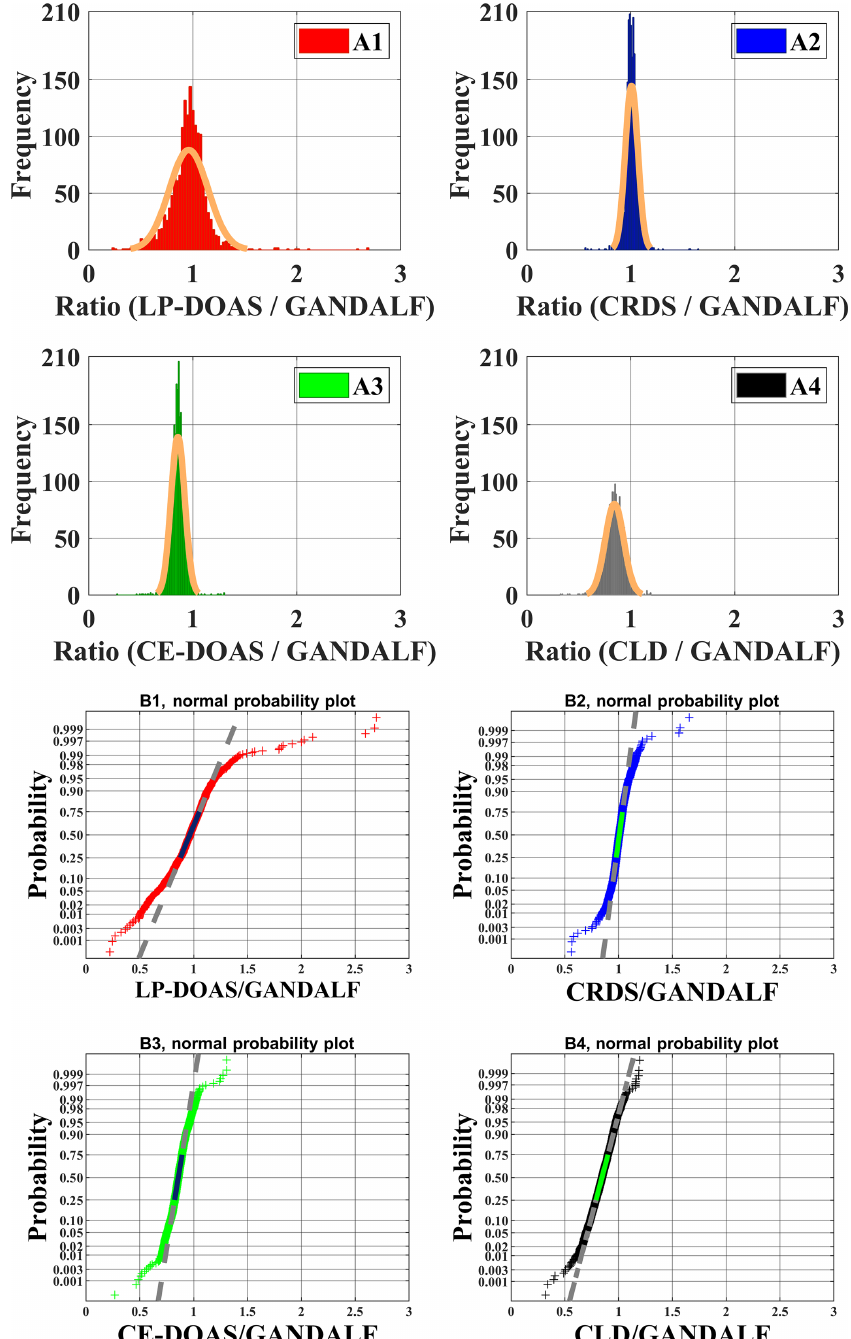
Figure 11. Distribution of comparative instrument ratios of NO 2 measurements from different instruments is shown in upper panels ( A1 to A4 ) and a normal probability plot for comparative instrument ratios is shown in lower panels ( B1 to B4 ).